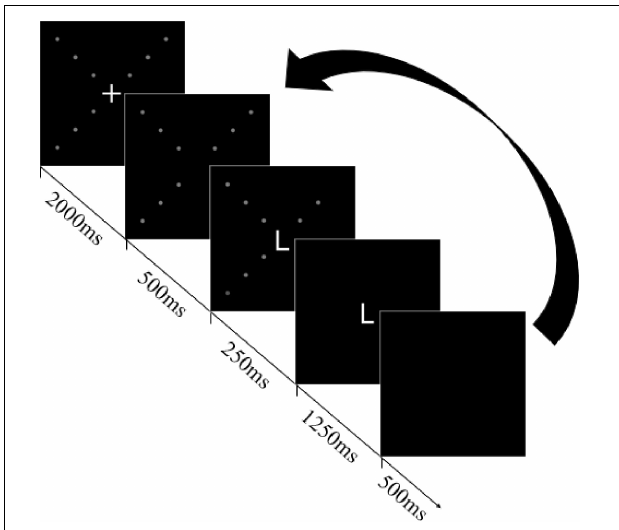
FIGURE 1 | The layout of stimulus (The white dashed line in the figure does not appear in the experimental task).